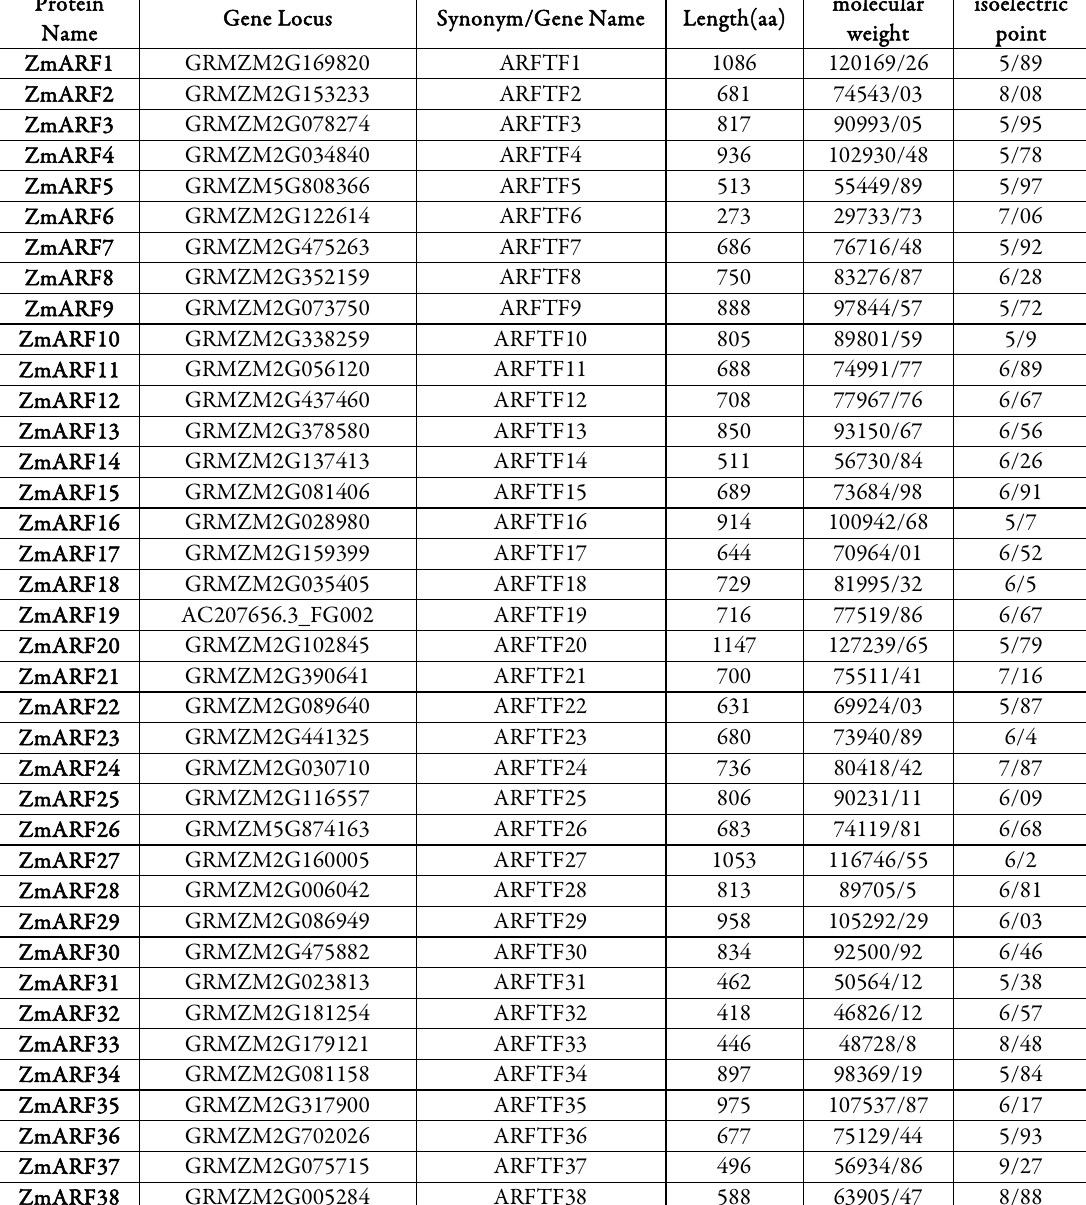
Table 1. Characteristics of ZMARF gene family in maize